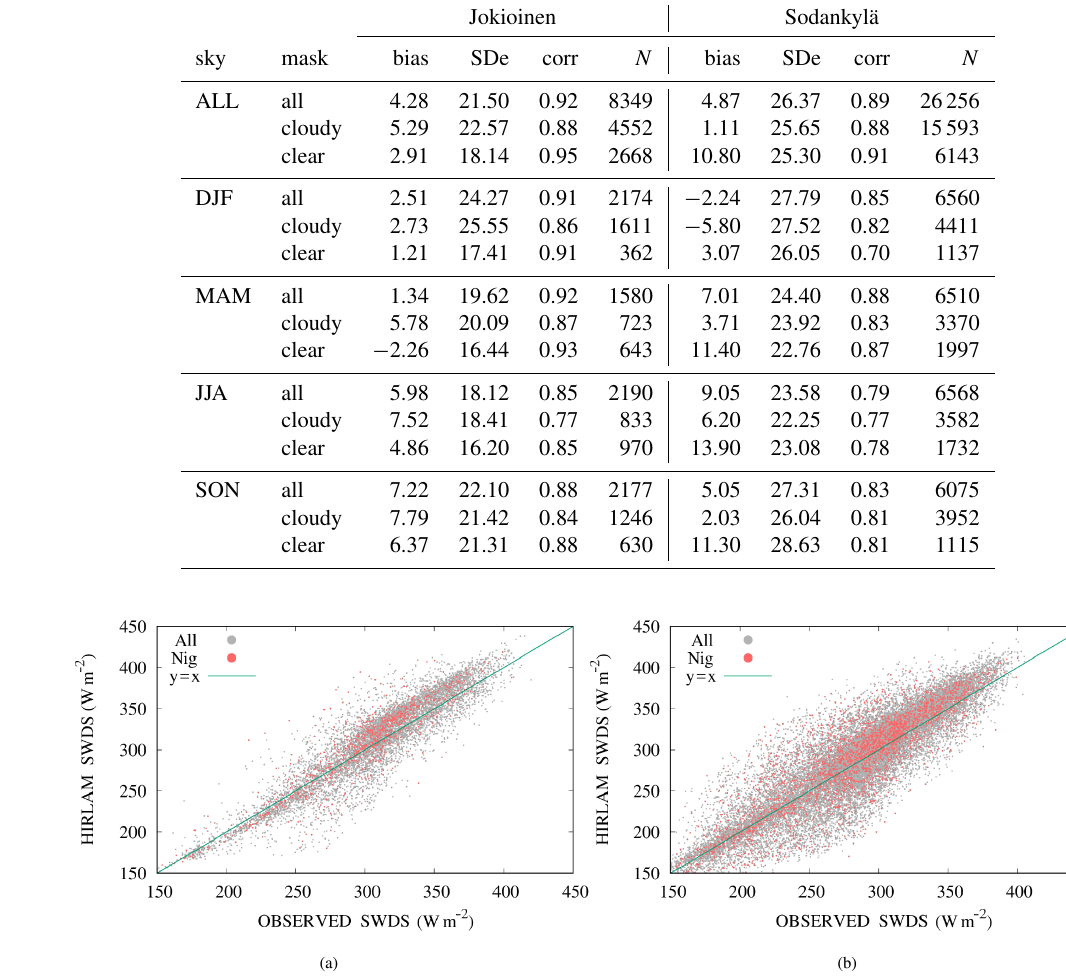
Figure 8. All predicted vs. observed LWDS: (a) Jokioinen and (b) Sodankylä. Night-time fluxes (23:00–02:00UTC or 00:00–03:00local time) are shown in red, grey dots denote all